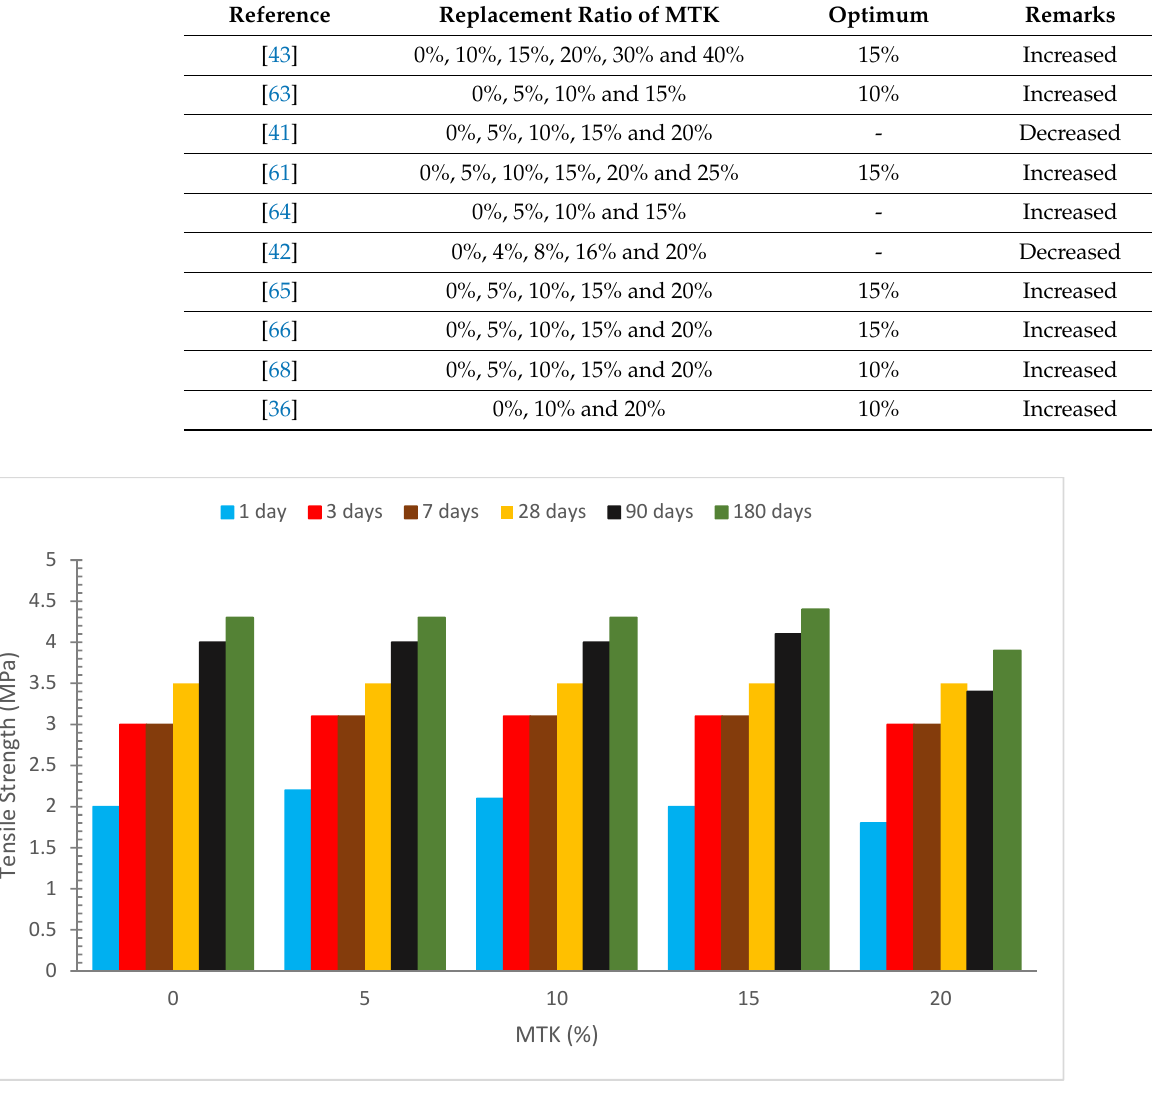
Figure 10. Tensile strength: Data source [65]. Table 5. Summary of the tensile strength of concrete.